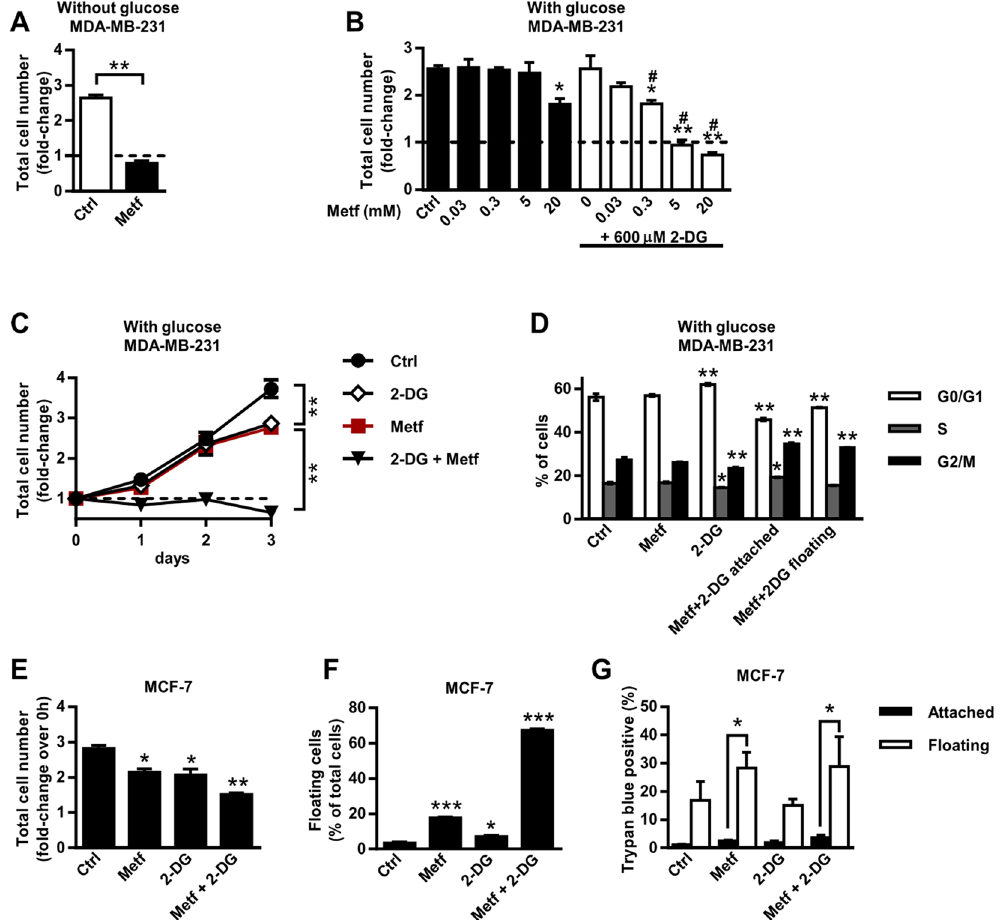
Figure 3. Combined treatment with 2-DG and metformin suppresses cell proliferation. ( A ) MDA-MB-231 cells were grown for three days in medium without glucose containing 5 mM metformin. Total number of cells in each sample was determined and normalized to the number of initially seeded cells. Results are means ± SEM (n = 4). ** P < 0 . 0001 . ( B,C ) MDA-MB-231 cells were grown for two days ( B ) or one to three days ( C ) in medium with (5.6 mM) glucose containing indicated concentrations of metformin and/or 600 µ M 2-DG. Total number of cells in each sample was determined and normalized to the number of initially seeded cells. Results are means ± SEM (n = 3–4). * P ≤ 0 . 05 ; ** P < 0 . 0001 . # Indicates synergism between metformin and 2-DG (see Supplementary Fig. S5). ( D ) MDA-MB-231 cells were treated with metformin and 2-DG for two days. Cell cycle was analysed using flow cytometry. Results are means ± SEM (n = 2). * P ≤ 0 . 05 vs. Ctrl; ** P < 0 . 0001 vs. Ctrl. ( E , F , G ) MCF-7 cells were treated with metformin and 2-DG for three days and their effects on total cell number ( E ), percentage of floating cells ( F ) and trypan blue positive cells ( G ) were analysed. Results are means ± SEM (n =